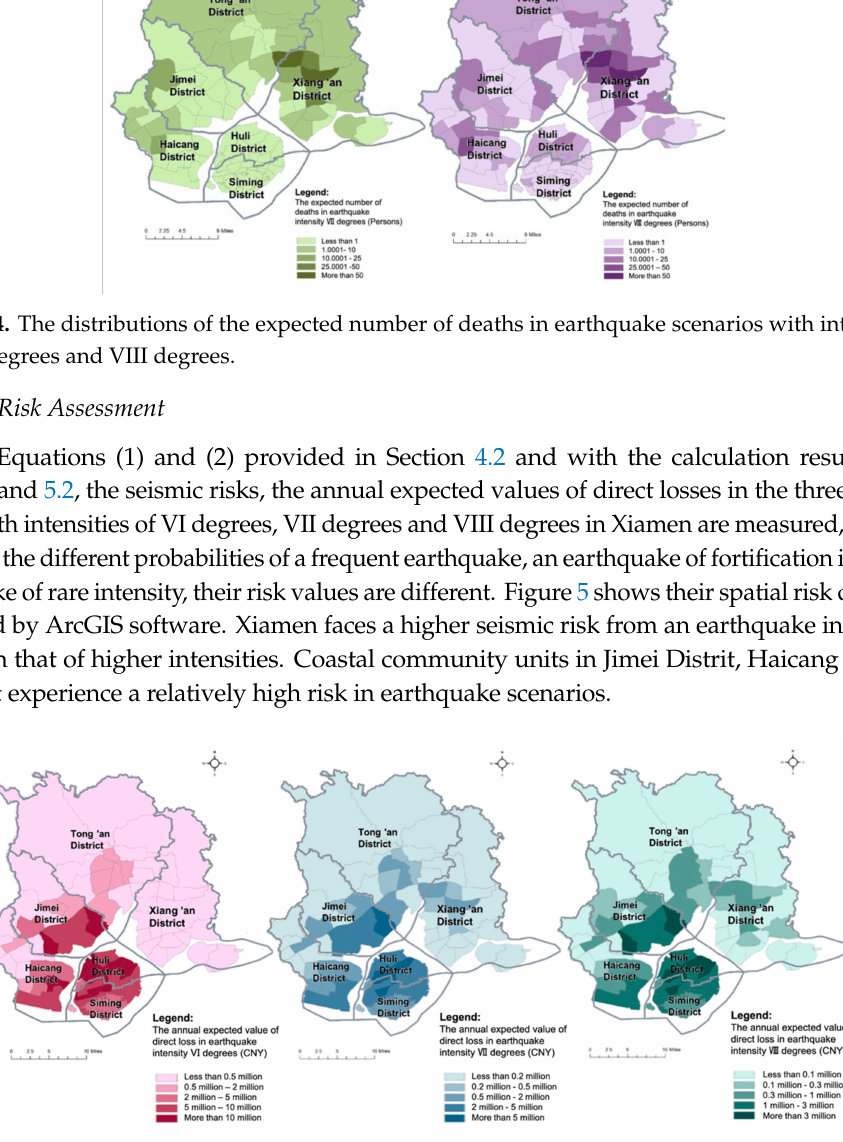
Figure 5. The seismic risk distribution (the distributions of the annual expected value of direct loss) in three earthquake